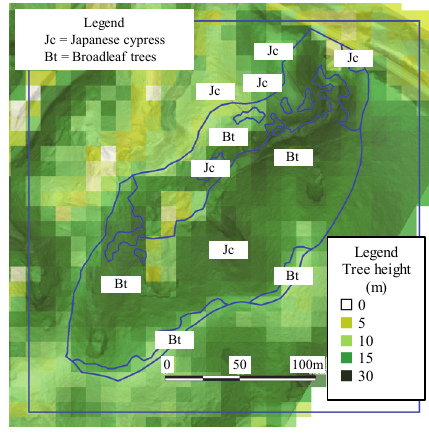
Legend Distribution of distance between trees (m) □ 0 ■ 1.5